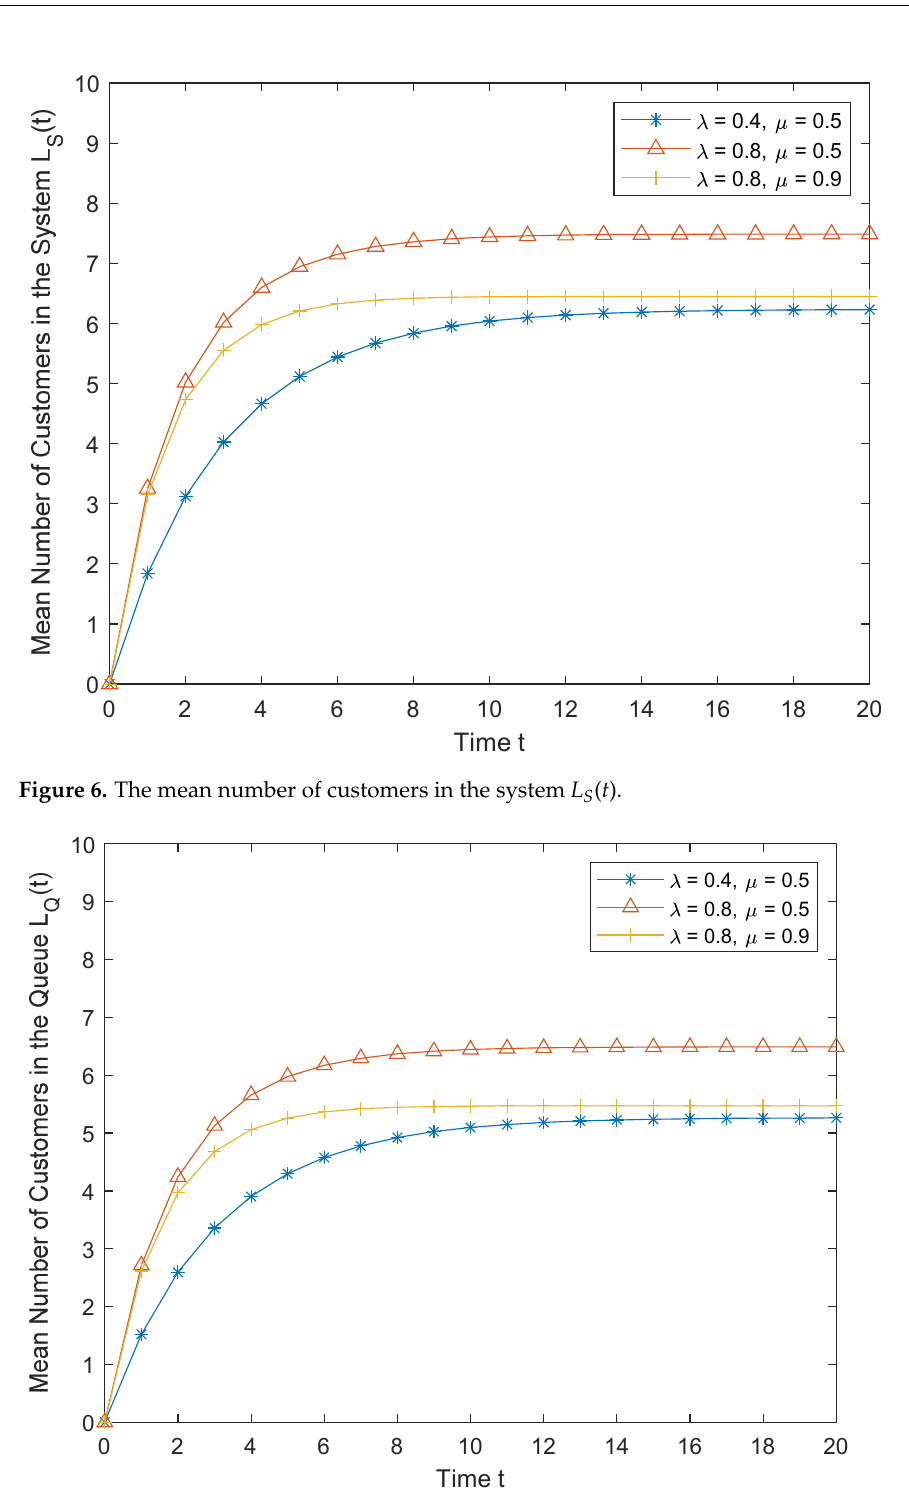
Figure 5. The queueing probability of the system P Q ( t ).